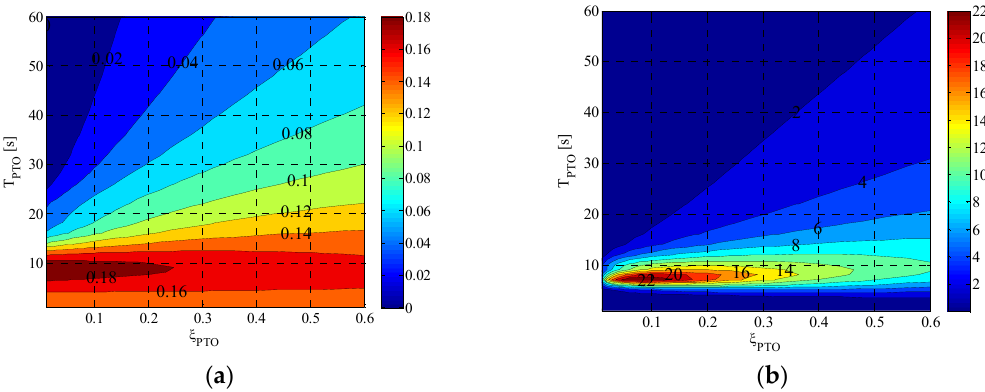
 and ; ( b ) the T PTO PTO T .  and PTO PTO